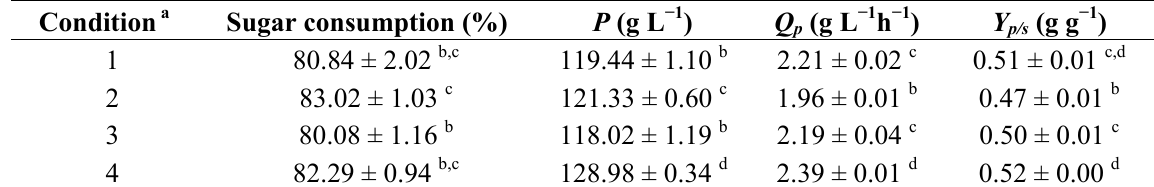
Table 3. Main fermentation parameters of batch ethanol production from the sweet sorghum juice containing 9 g L − 1 of yeast extract under the four conditions of the preliminary